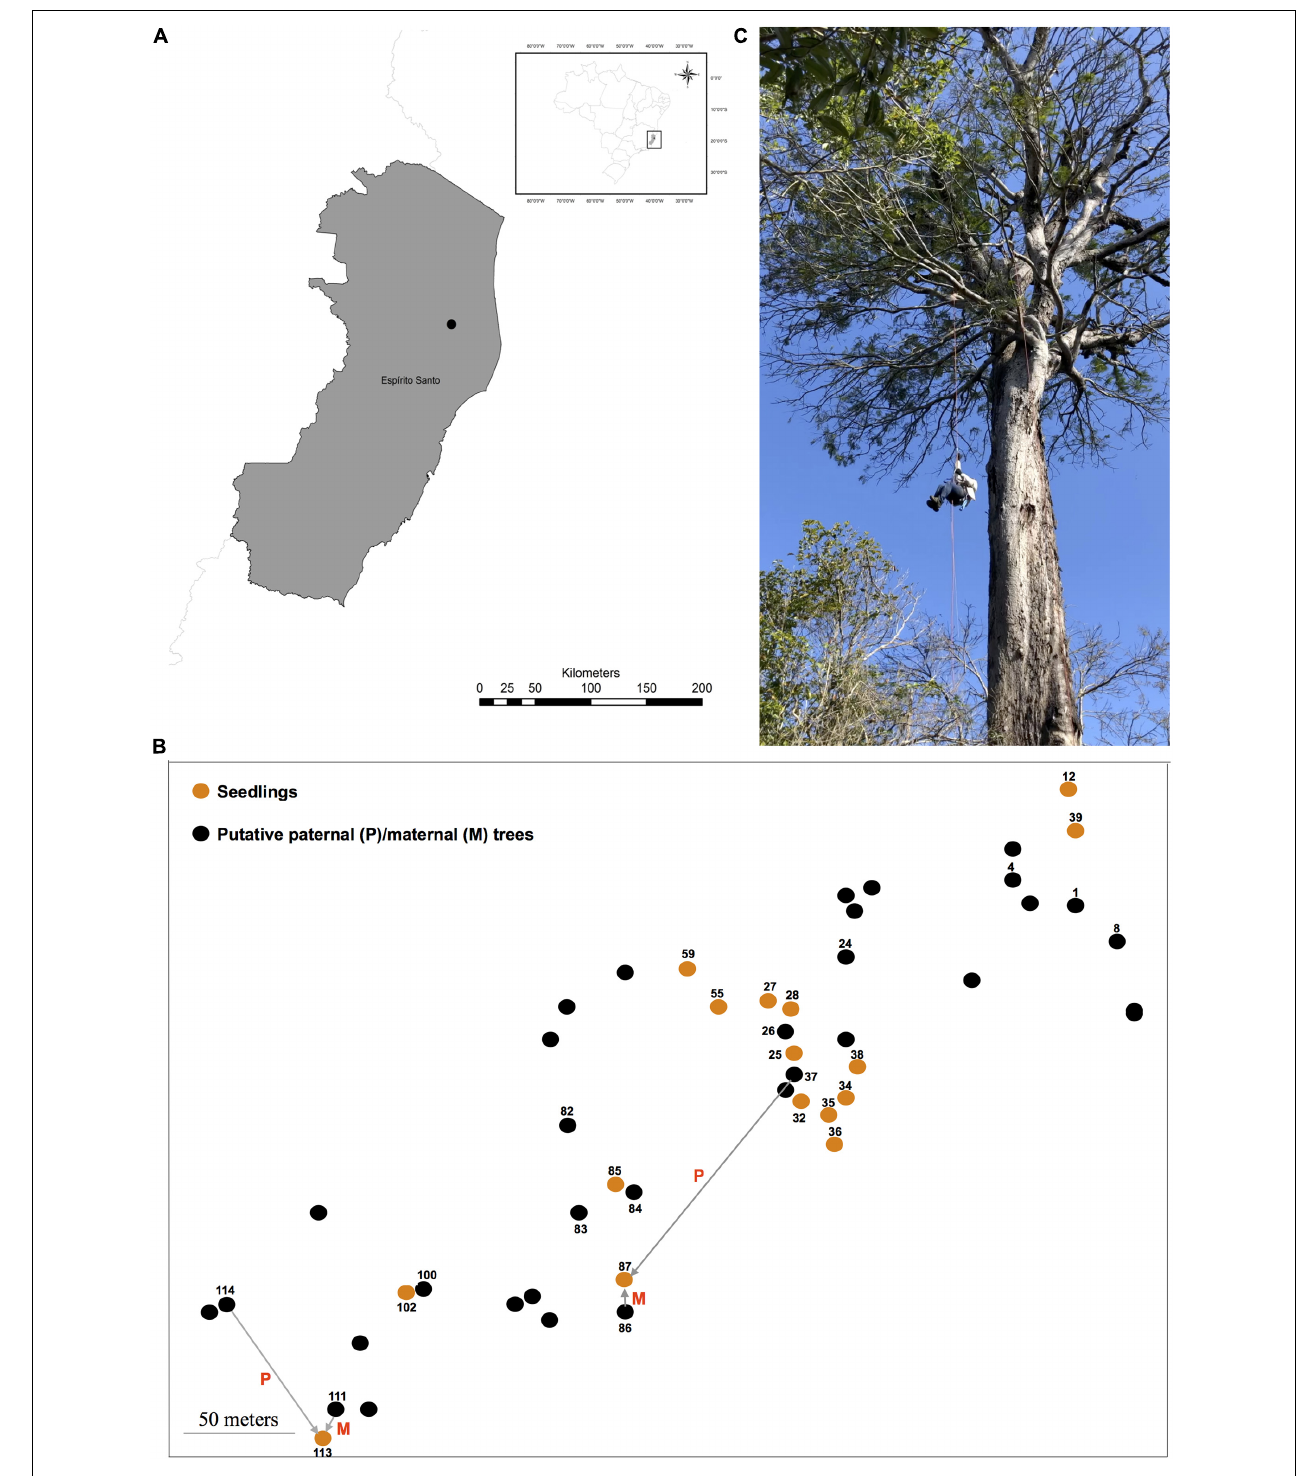
FIGURE 1 | The location (A) of the studied population (black dot) in the Atlantic Forest (Reserva Natural Vale, Espírito Santo State, Southeast Brazil). The spatial distribution of reproductive trees (i.e., putative maternal and/or paternal parents) and seedlings of Dinizia jueirana-facao sampled in the small population is shown in (B) . The reproductive trees (black dots) that were assigned as a maternal and/or paternal parent of the seedlings (orange dots) are also shown in (B) (displayed numbers; see Table 3 to identify the maternal and/or paternal parents of the seedlings as shown for seedlings 87 and 113). An image of an adult tree (C) is also